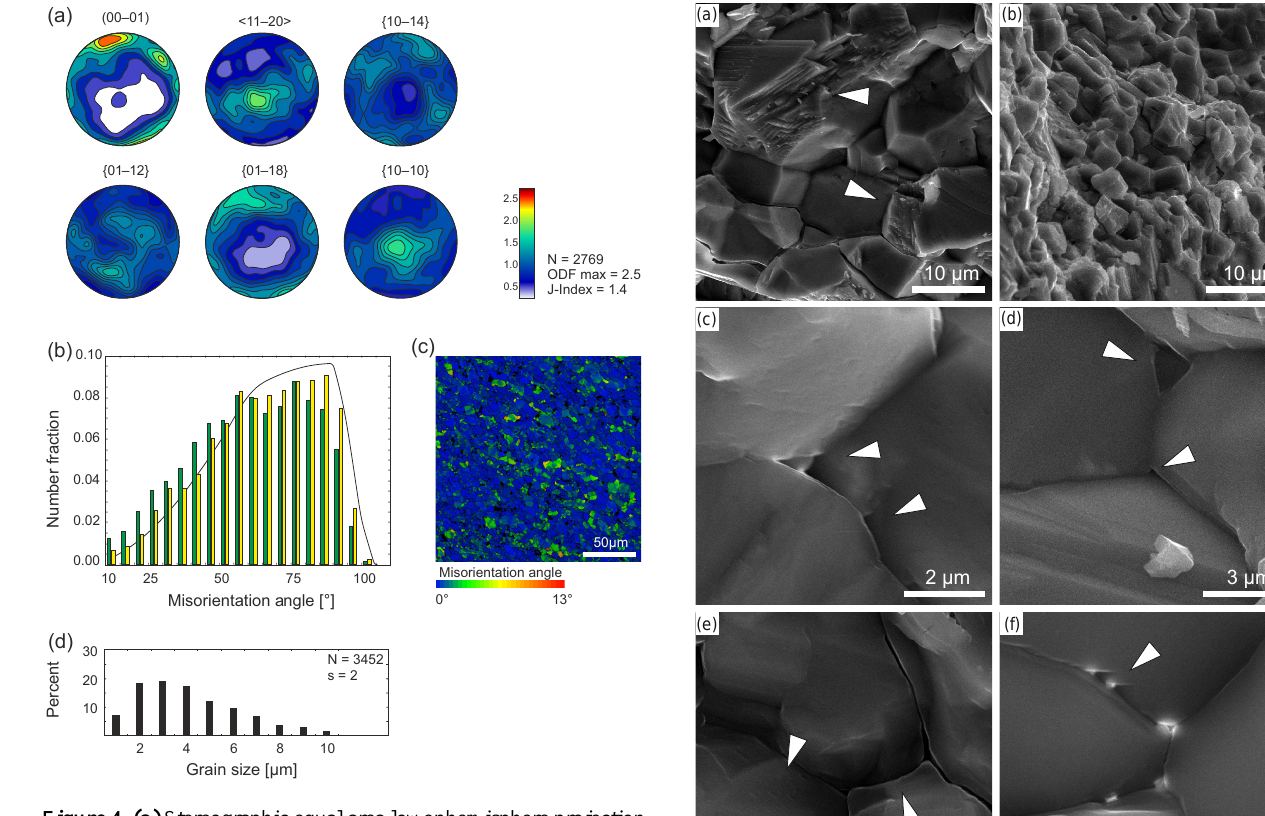
Figure 4. (a) Stereographic equal area lower hemisphere projection of c (0001) and − a < 11 − 20 > axes and poles of r { 10 − 41 } , f { 0 − 12 } , e { 01 − 18 } and m { 10 − 10 } planes. N represents the number of analysed grains. Texture strength is represented by the intensity of the orientation distribution function (ODF); addition- ally, information on the J index is given. (b) Histogram showing the misorientation-angle distribution of neighbour-pair (green) and random-pair grains (yellow). The curve represents the calculated theoretical curve for a perfectly random misorientation-angle distri- bution for trigonal crystal symmetry. (c) Orientation deviation map representing the misorientation over each grain with respect to its average misorientation. (d) Grain-size histogram of UFG. N de- notes the total number of analysed grains; s denotes standard devi- ation.